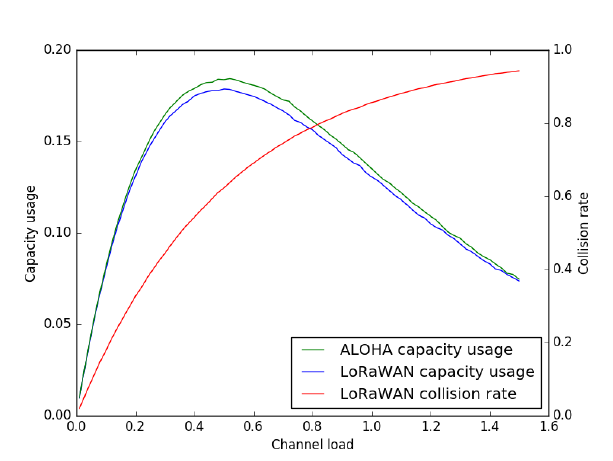
Figure 10. Link capacity usage and packet collision rate for a LoRaWAN network and compared to an ALOHA network. The load is as defined in Section 5.2.